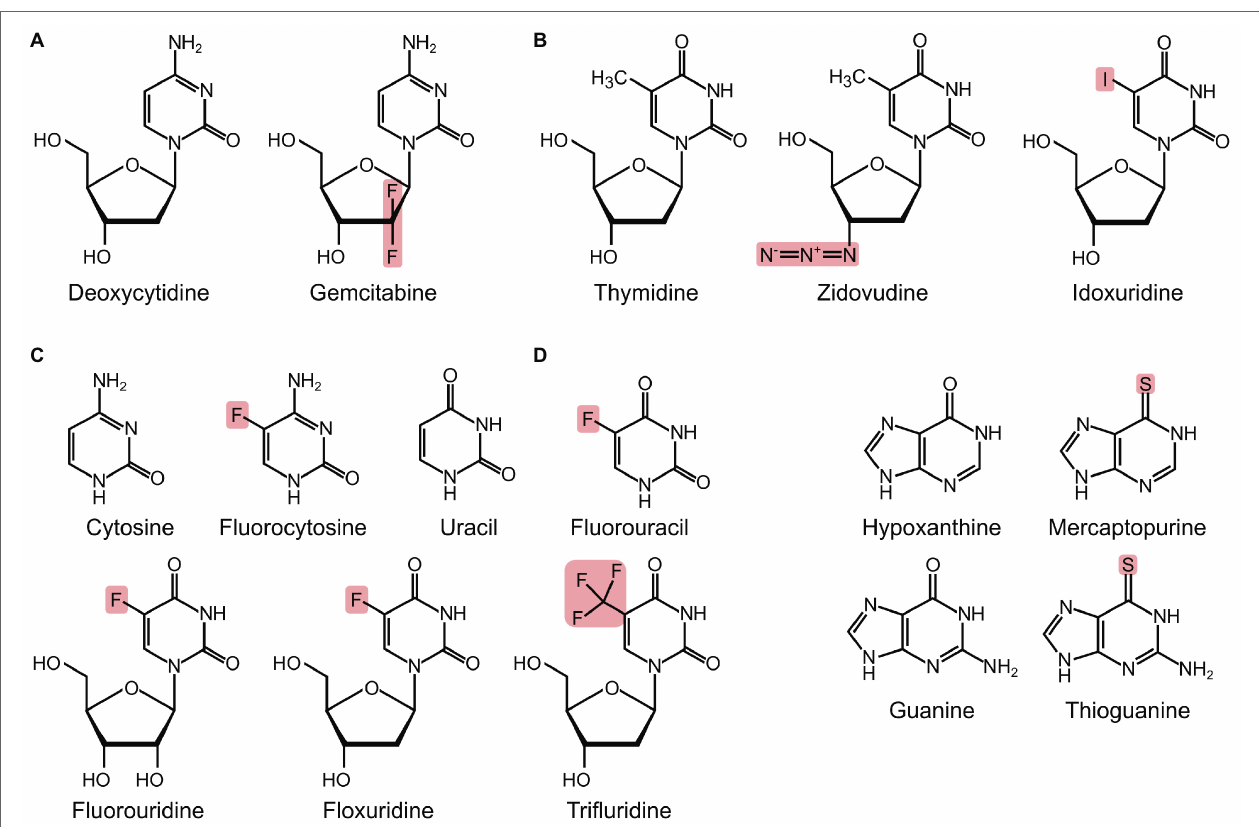
FIGURE 2 | Structures of pyrimidines, purines, and their analogues, with substituted atoms highlighted. (A) Deoxycytidine and its analogue. (B) Thymidine and its analogues. (C) Cytosine, uracil, and fluorinated pyrimidines. (D) Hypoxanthine, guanine, and their